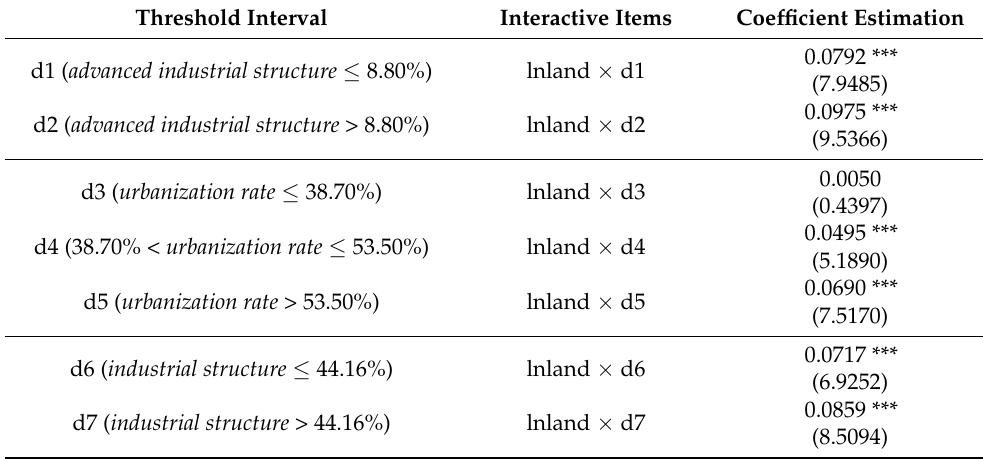
Table 10. Regression results showing the threshold effect of transportation land transfer on eco- nomic